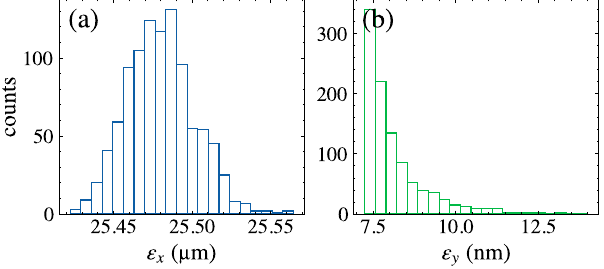
FIG. 6. Histogram of final horizontal (a) and vertical (b) emit- tances simulated downstream of the EEX beamline for 1000 realizations of SRF-cavity random phase and amplitude